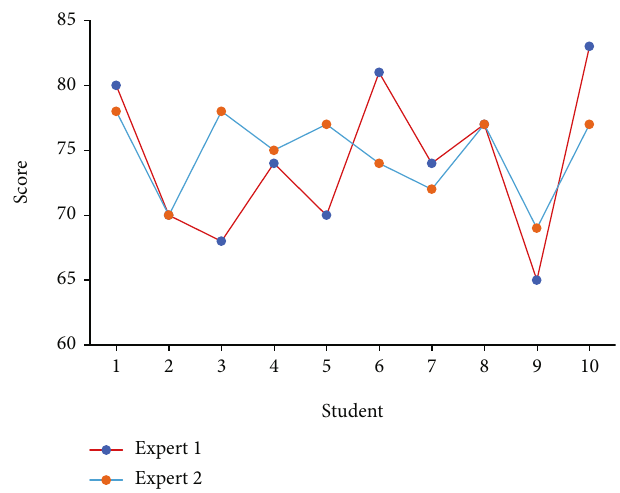
Figure 6: Ranking of students ’ overall quality score.